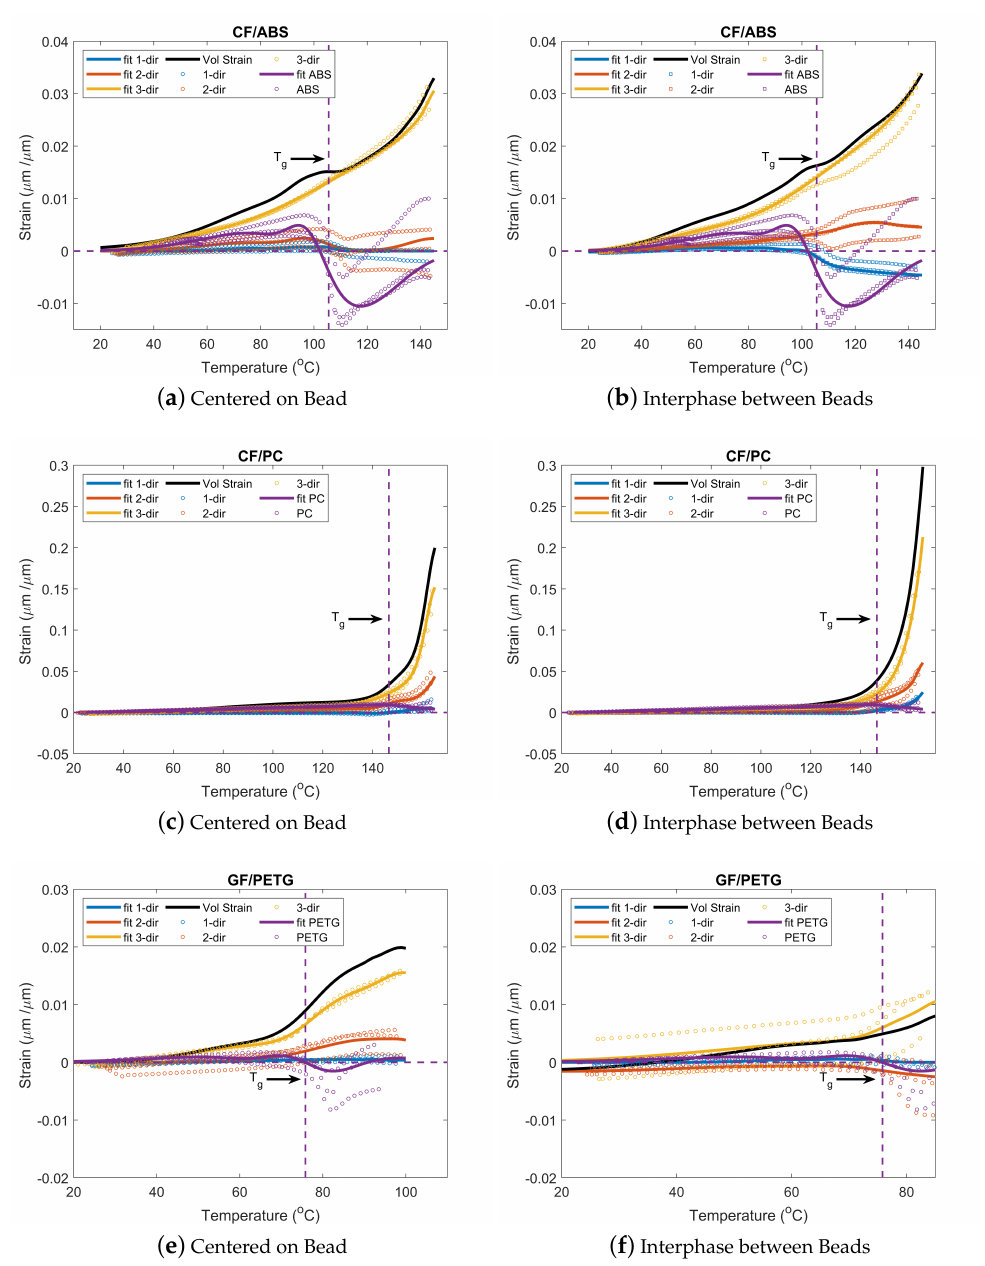
Figure 8. Strain as a function of temperature for ( a ) CF/ABS COB; ( b ) CF/ABS IBB; ( c ) CF/PC COB; ( d ) CF/PC IBB; ( e ) GF/PETG COB; and ( f ) GF/PETG